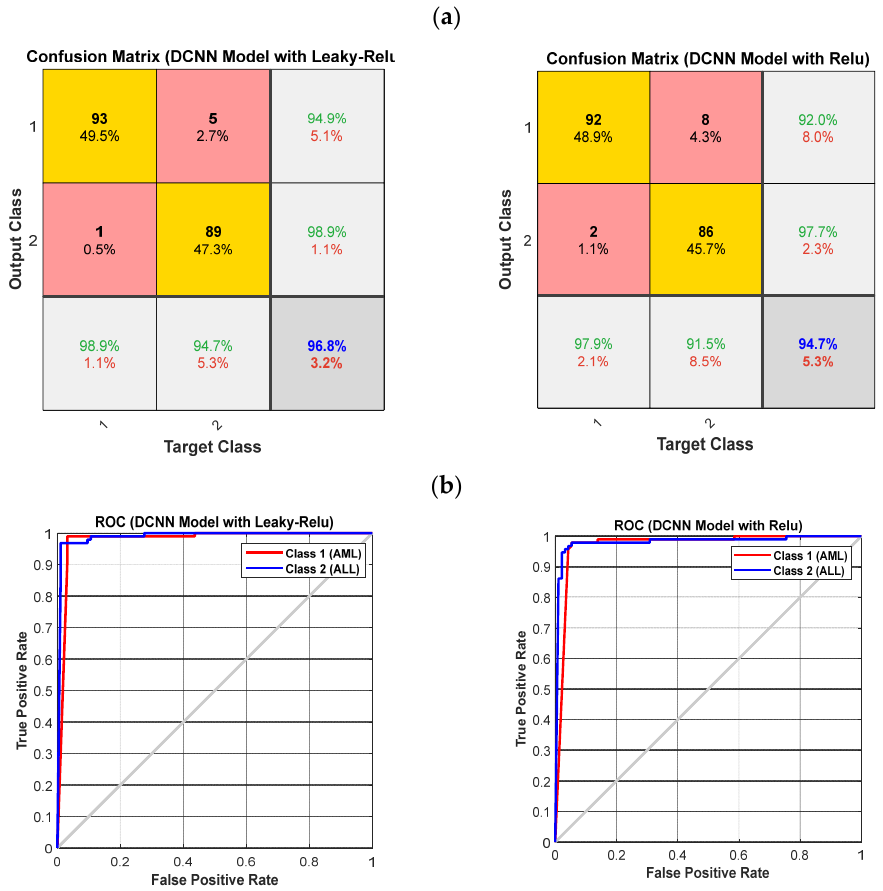
Figure 9. The confusion matrixes and ROC diagrams for the DCNN model with Relu and Leaky-Relu activation functions; ( a ) the confusion matrixes; and ( b ) the ROC diagrams.